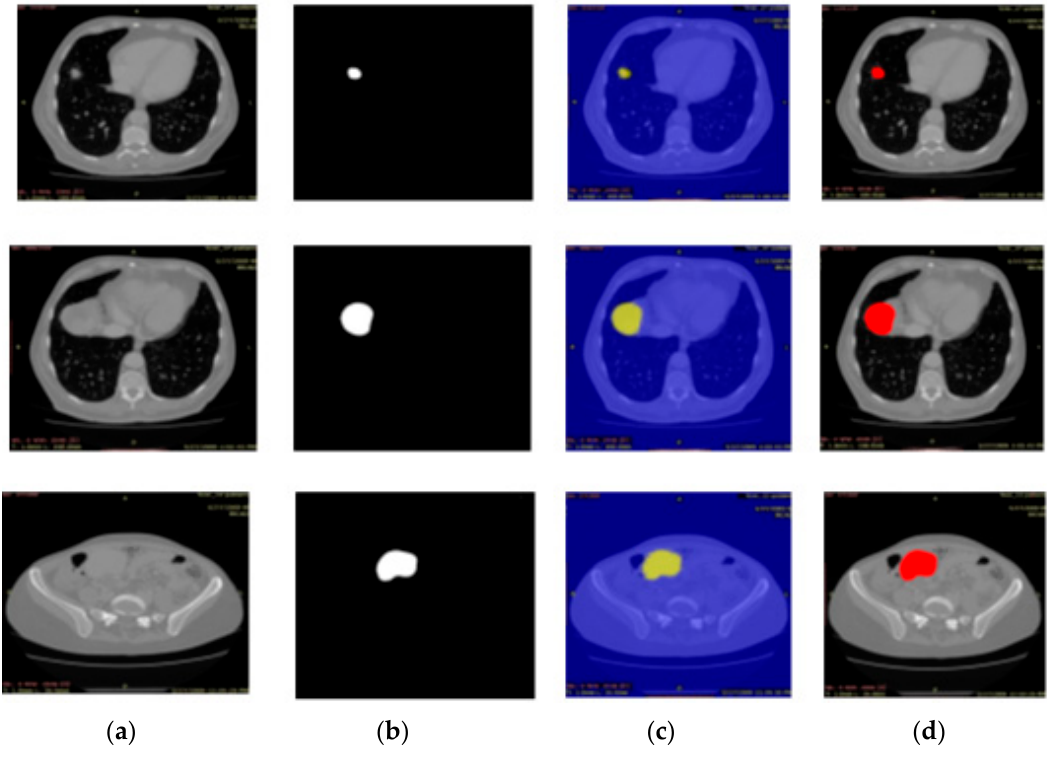
Figure 12. 3D-semantic liver segmentation ( a ) CT liver ( b ) binary segmentation ( c , d ) 3D-annotated.